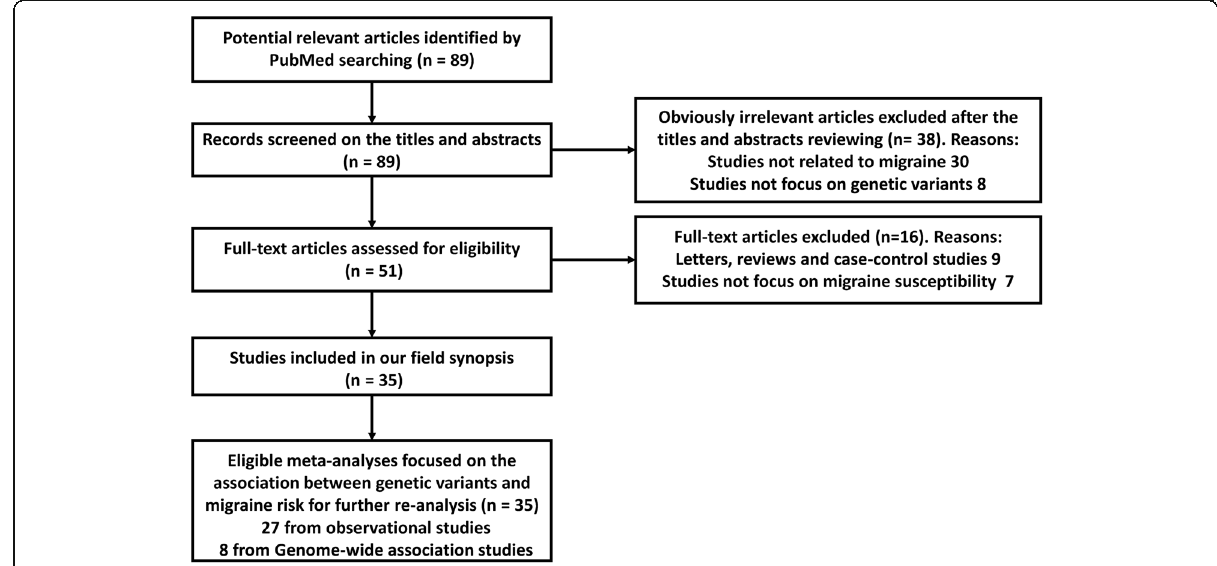
Fig. 1 The flow chart of the articles screening and